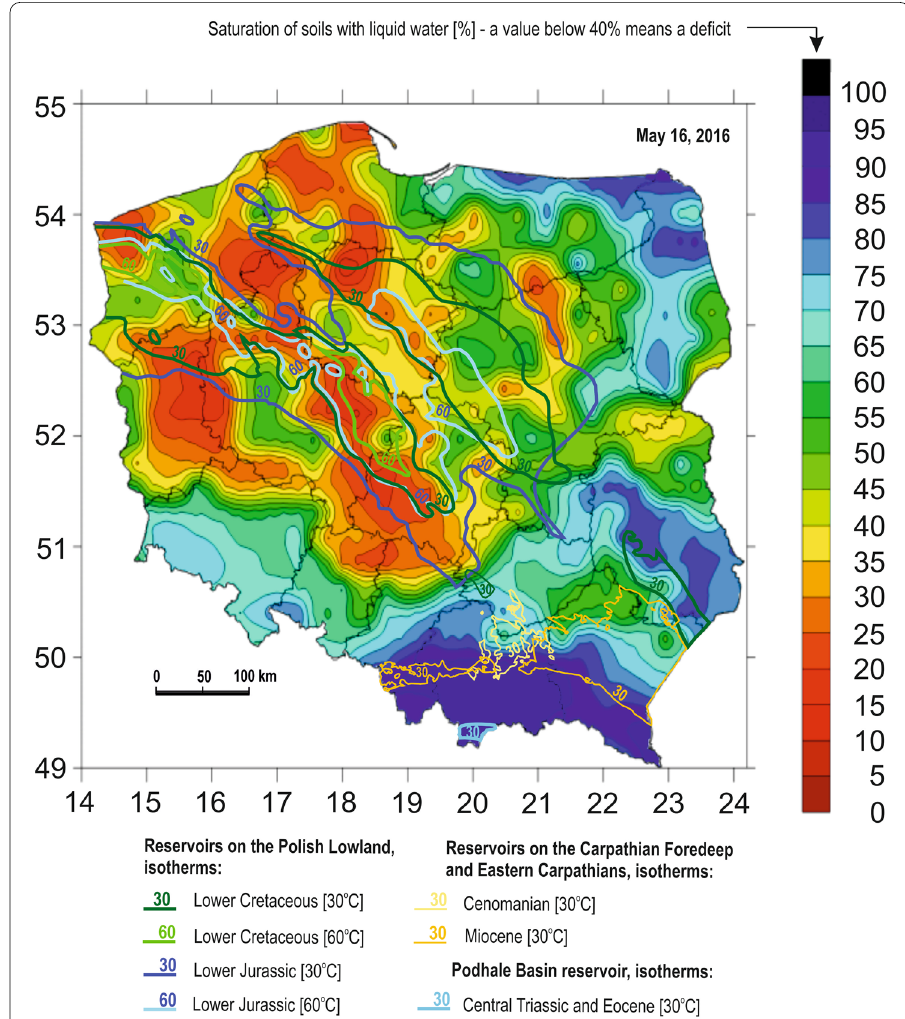
Fig. 2 Geothermal water reservoirs proposed for agricultural uses in Poland against the map of soil moisture indicators. Explanations regarding the soils moisture index: a colorful scale of % saturation of soils with liquid water at a depth interval of 0.7–0.28 m. Scientific description based on Barbacki et al. (2016) ; ranges of reservoirs with temperatures > 30 ◦ C and > 60 ◦ C according to maps by Górecki et al. (2006, 2011, 2012, 2013); saturation of soils with liquid water according to MARD (2017), IMWM‑NRI (2021)—sample data from May 16,